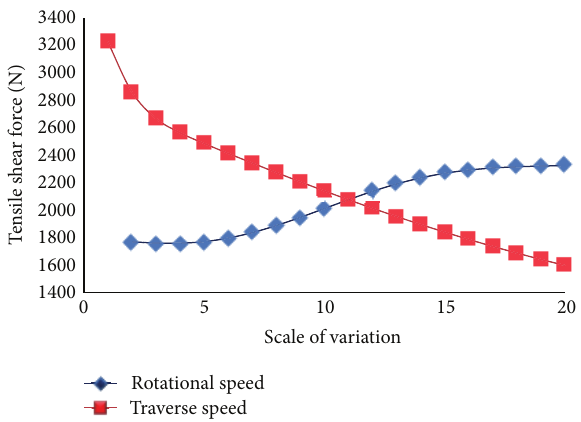
Figure 8: Contribution of variables used in the ANN model for tensile shear force, by the Profile algorithm with scale of 20. Table 4: Sensitivity analysis for tensile shear force. ANN model